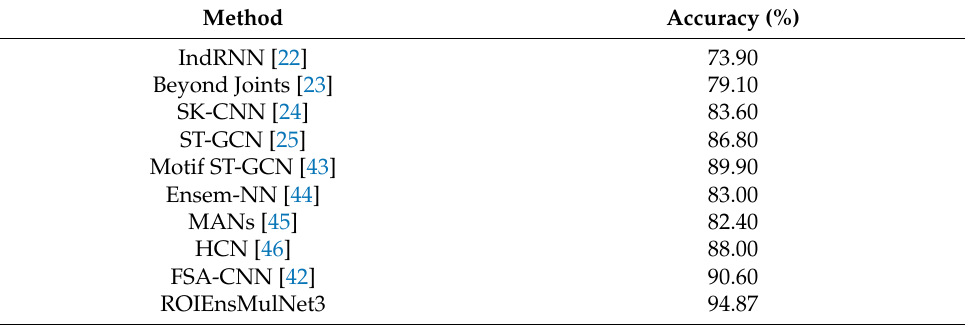
Table 5. Performance comparison with conventional behavior recognition methods (CS).